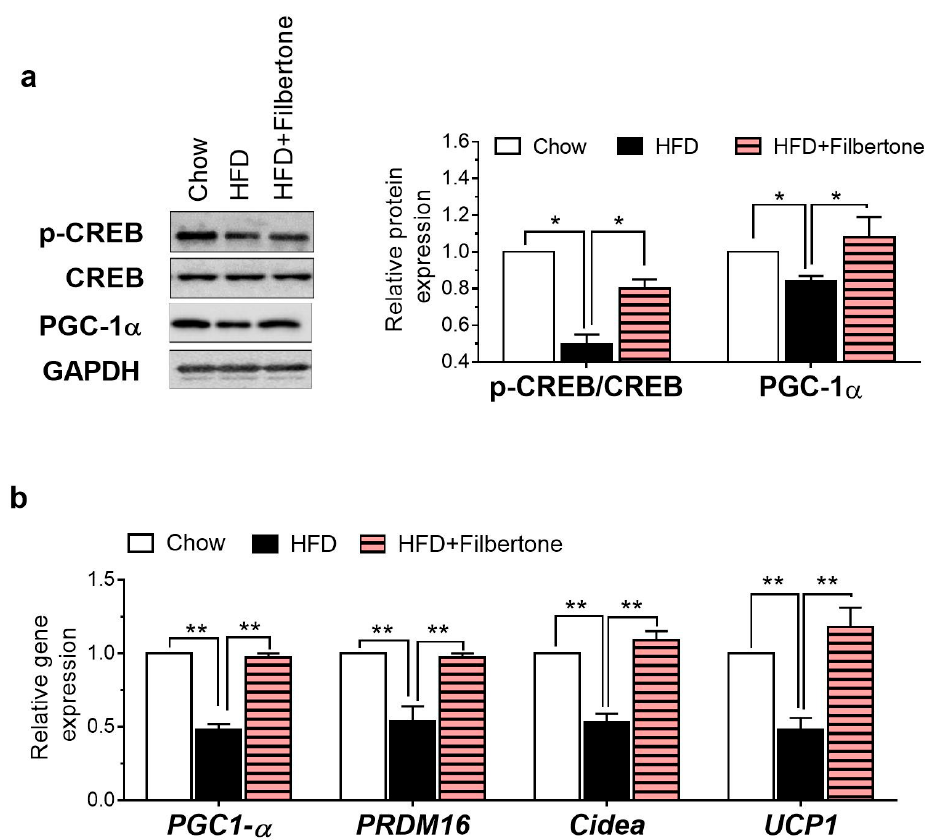
Figure 4. Filbertone regulates the expression of thermogenesis-related factors in adipose tissue. ( a ) Protein levels of phosphorylated cAMP-responsive element-binding protein (p-CREB), cAMP-responsive element-binding protein (CREB), and PGC1 α in the adipose tissue. ( b ) Real time RT-PCR analysis of PGC1- α , PRDM16 , Cidea , and UCP1 in the adipose tissue. * p < 0.05, ** p < 0.01, and *** p < 0.001, between the groups. Values are means ± SEM.